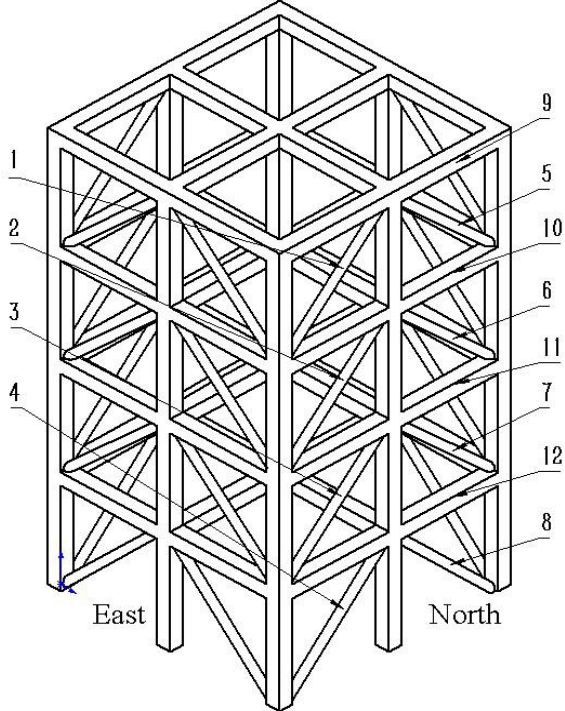
Figure 1. The 3D model of the four-story steel frame structure.